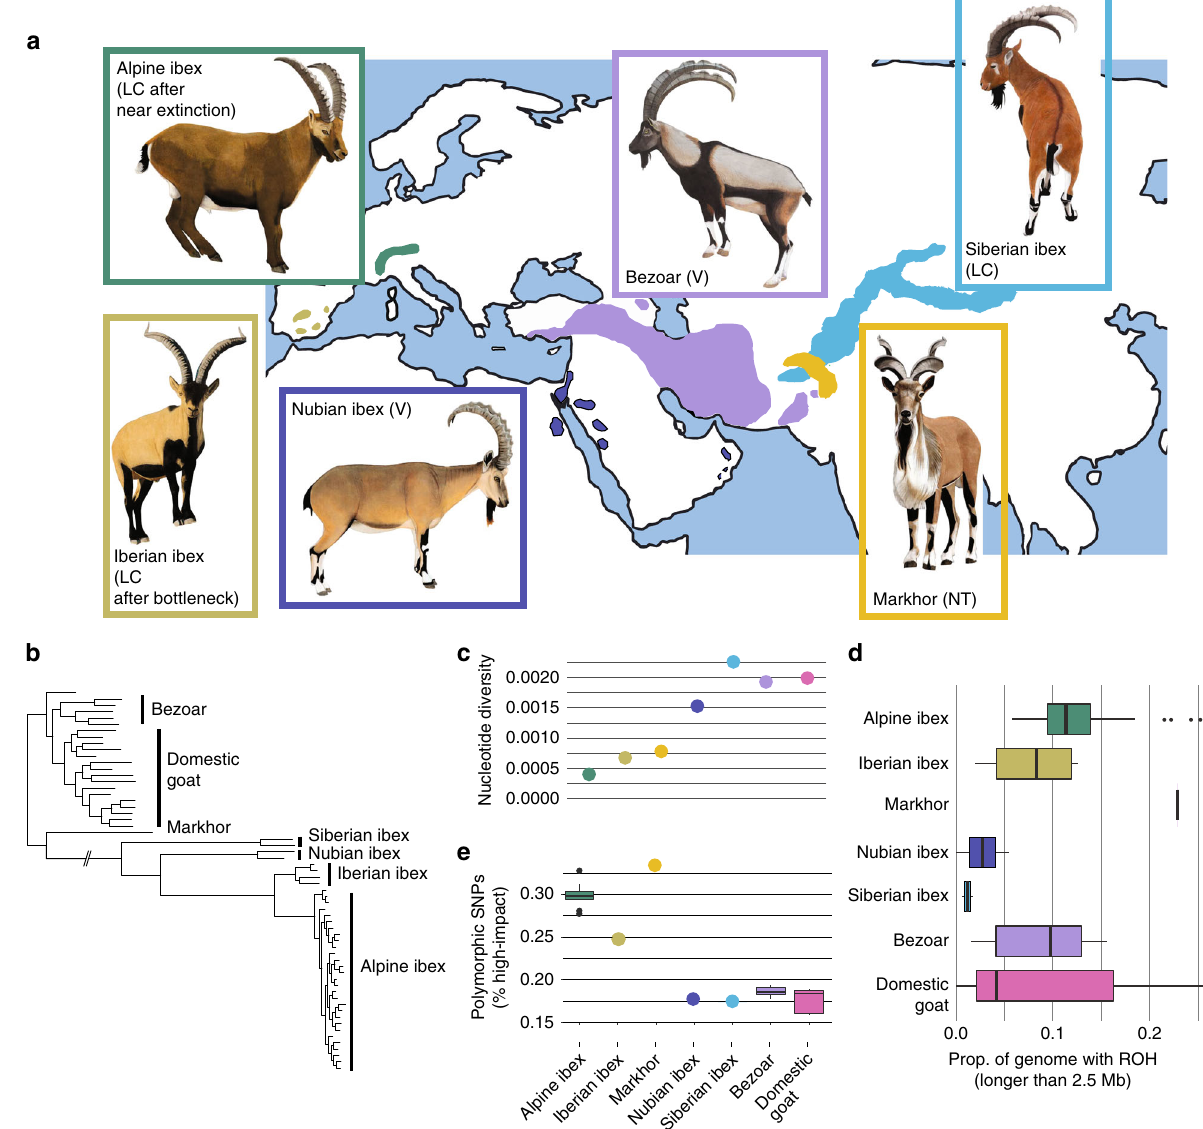
Fig. 1 Genetic diversity and deleterious mutation load of ibex species. a Geographical distribution and IUCN conservation status of ibex and wild goat species (LC: Least concern, V: Vulnerable, NT: Near threatened 39 ). Sample sizes: Alpine ibex ( C. ibex ): N = 29, Iberian ibex ( C. pyrenaica ): N = 4, Bezoar ( C. aegagrus ): N = 6, Siberian ibex ( C. sibirica ): N = 2, Markhor ( C. falconeri ): N = 1, Nubian ibex ( C. nubiana ): N = 2. b Maximum likelihood phylogenetic analyses, ( c ) nucleotide diversity, ( d ) proportion of the genome with runs of homozygosity (ROH) longer than 2.5 Mb and ( e ) percentage of polymorphic sites within species that segregate highly deleterious mutations. Con fi dence intervals are based on downsampling to four individuals matching the sample size of Iberian ibex (100 replicates). Boxplots show the median, the 25th and 75th percentiles, Tukey whiskers (median ± 1.5 times interquartile range), and outliers ( (cid:129) ). Source data are provided as a Source Data fi